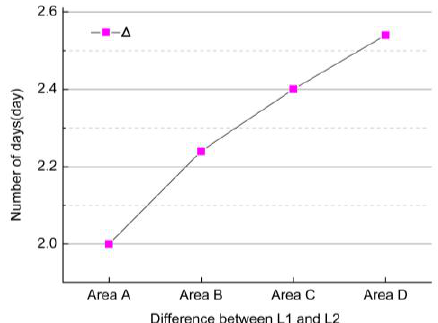
Figure 6. The differences ( ∆ i ) between L1 and L2 varied from the four experiment areas (Area A, Area B, Area C, and Area D), respectively.